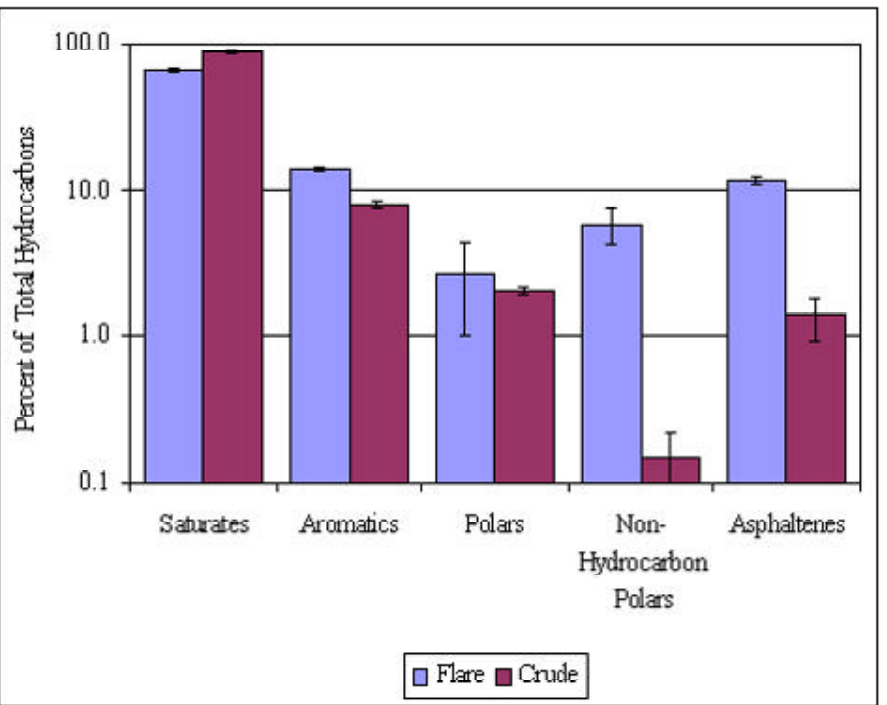
FIGURE 2 . Hydrocarbon type distribution of crude whole and flare whole